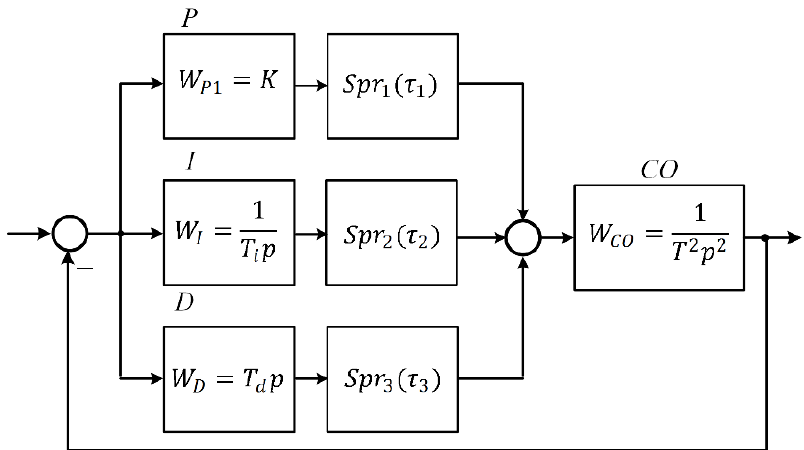
Figure 3. Block diagram of a second-order plant control system with a PID controller with separate controller channels (P-proportional, I-integral and D-differential channels) and different sampling intervals of these channels.